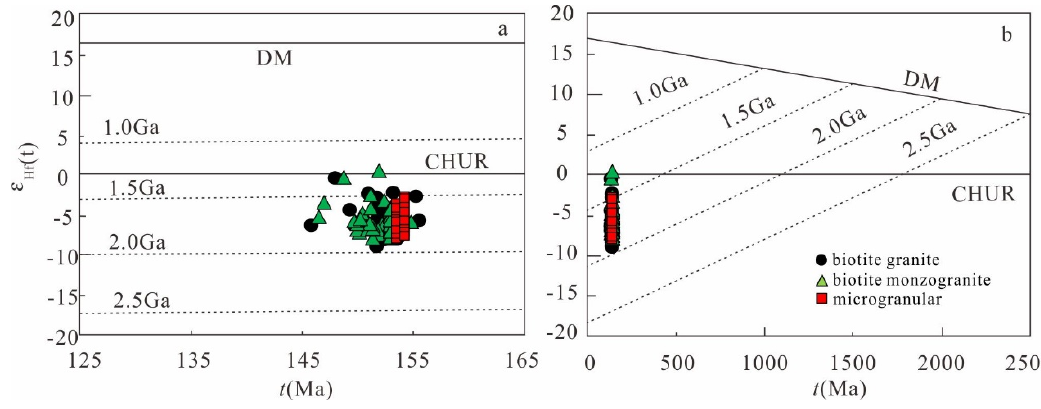
Figure 13. ( a ) U-Pb ages vs. ε Hf (t) diagram of zircon of the host granites and ( b ) MEs from the Xitian intrusion.